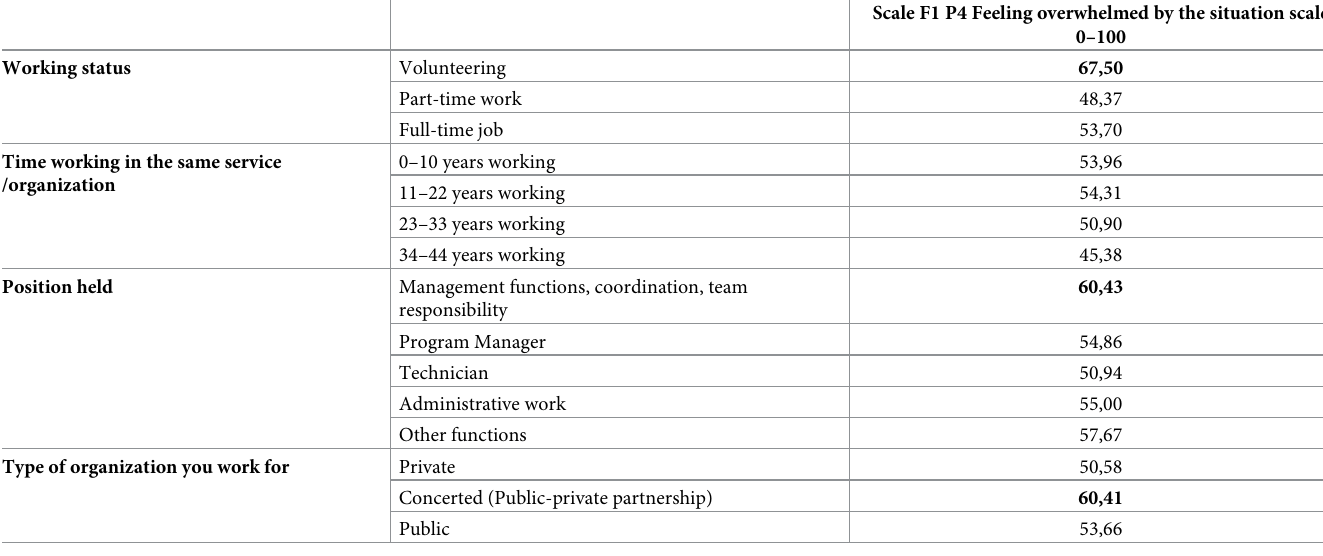
Table 5. Workplace characteristics of people who feel overwhelmed by the